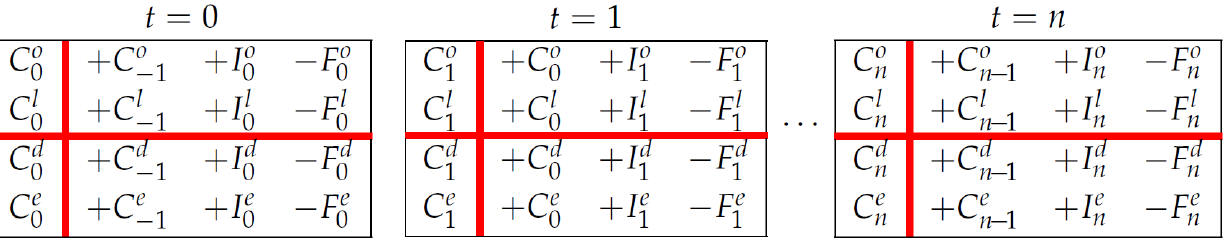
Figure 5. The split-screen film or strip (discrete format) (reprinted from Part I, Equation (66)).